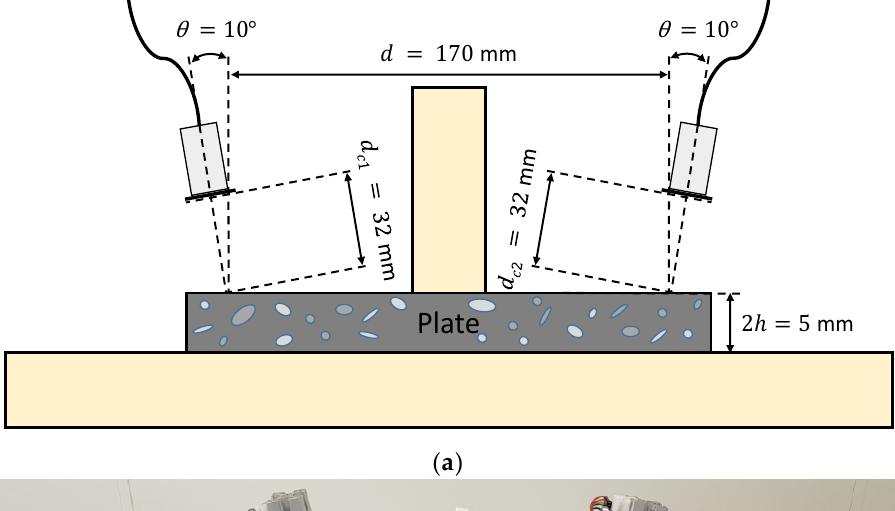
Figure 19. Air coupling setup to measure the mortar plate: ( a ) Schematic; ( b ) Photograph.